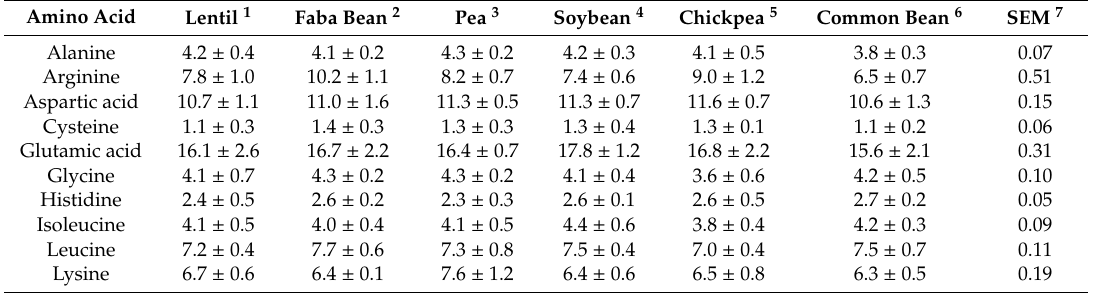
Table 4. Amino acid composition ± standard deviation (g / 16 g N) in seeds of six major grain legumes. Amino